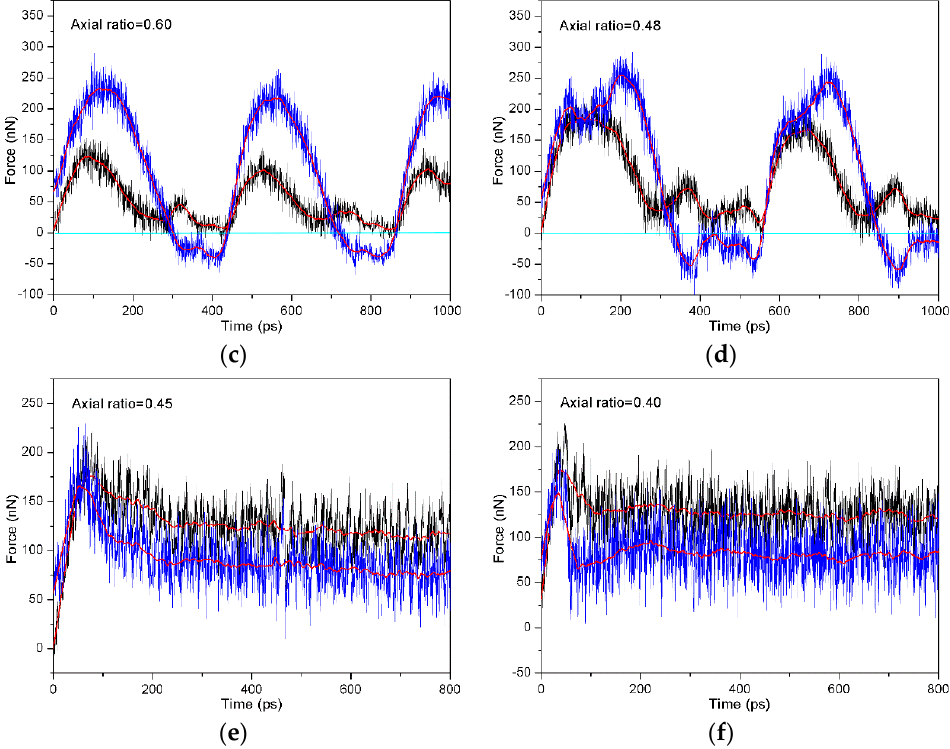
Figure 5. Friction force and normal force vs. time at different axial ratio ( a ) 1.00, ( b ) 0.80, ( c ) 0.60, ( d ) 0.48, ( e ) 0.45, and ( f ) 0.40. Black line is friction force, blue line is normal force and red line is the fitness.